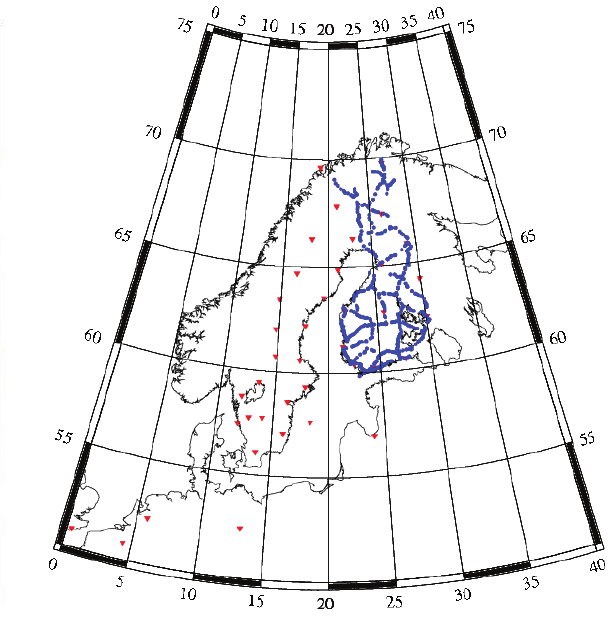
Fig. 2. Land uplift data points used in this study. BIFROST points are painted red, Finnish precise levelling points are